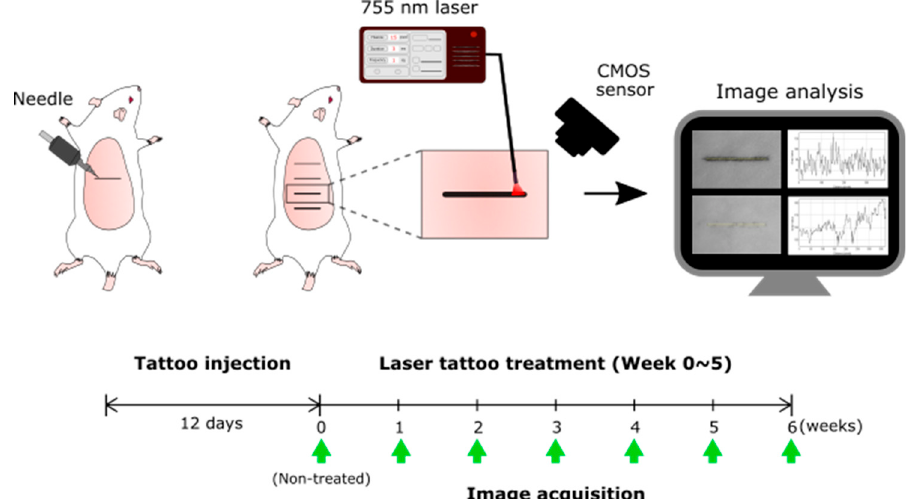
Figure 1. Experimental setup to quantitatively monitor the laser tattoo treatment. Green arrows represent the specific times for image acquisition. Note that each image was acquired one week after each laser treatment (CMOS: complementary metal-oxide-semiconductor).